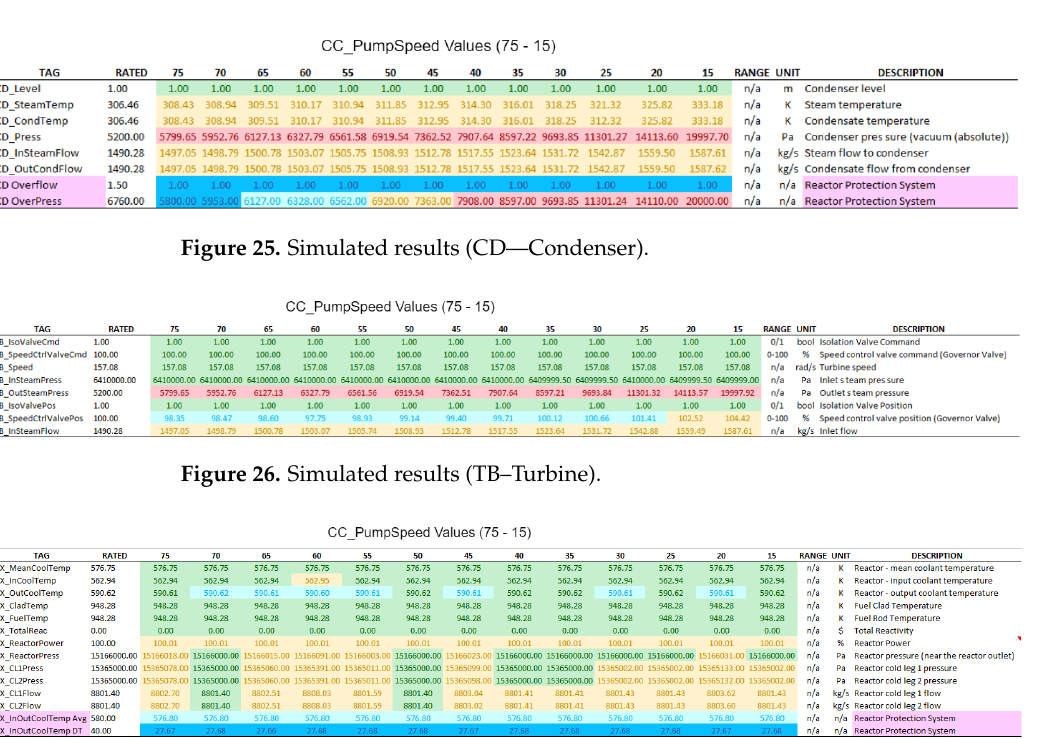
Figure 24. Simulated results (CC—Condenser Cooling).